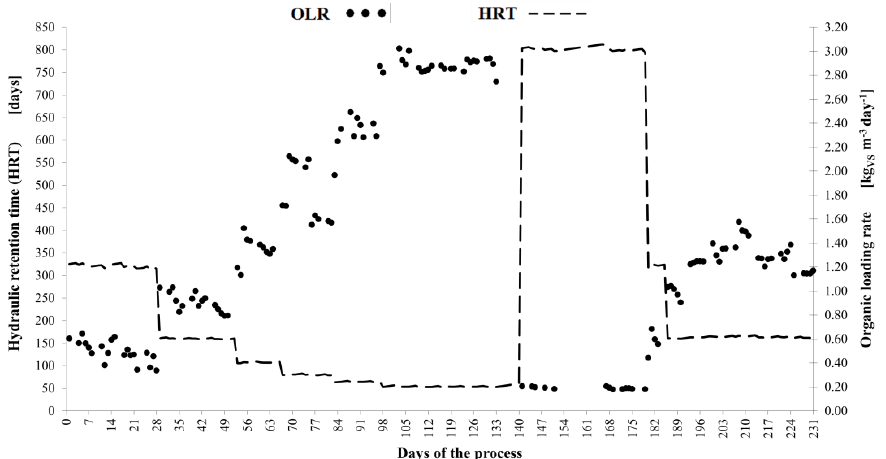
Figure 3. Relation between organic loading and retention time.